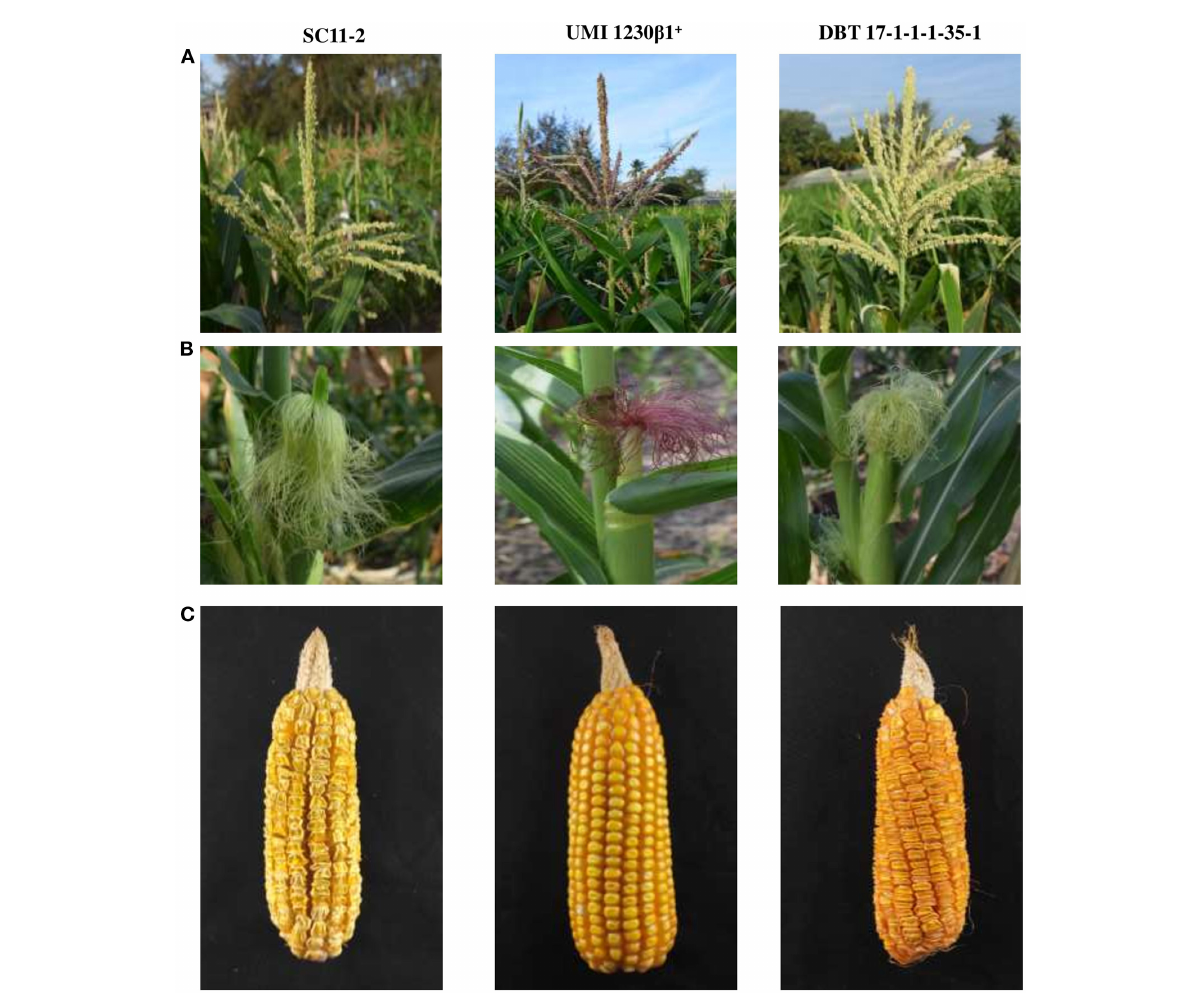
FIGURE4 The morphological traits [ (A) tassel, (B) silk, and (C) cob] in parents and improved line (DBT 17-1-1-1-35-1) from BC 2 F 3 generation of SC11-2 × UMI 1230 β 1 +